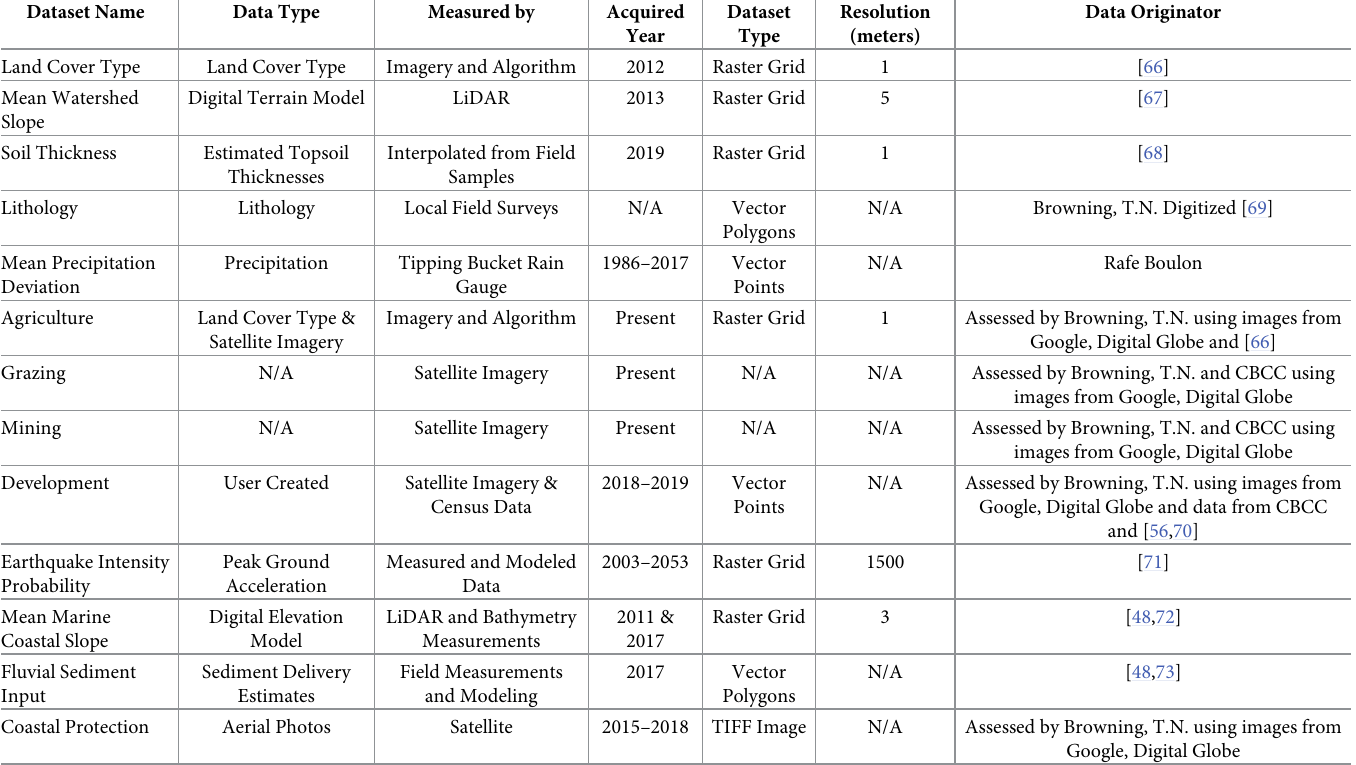
Table 1. All variables used in the EVI-STJ & EDVI-STJ with their resolutions and